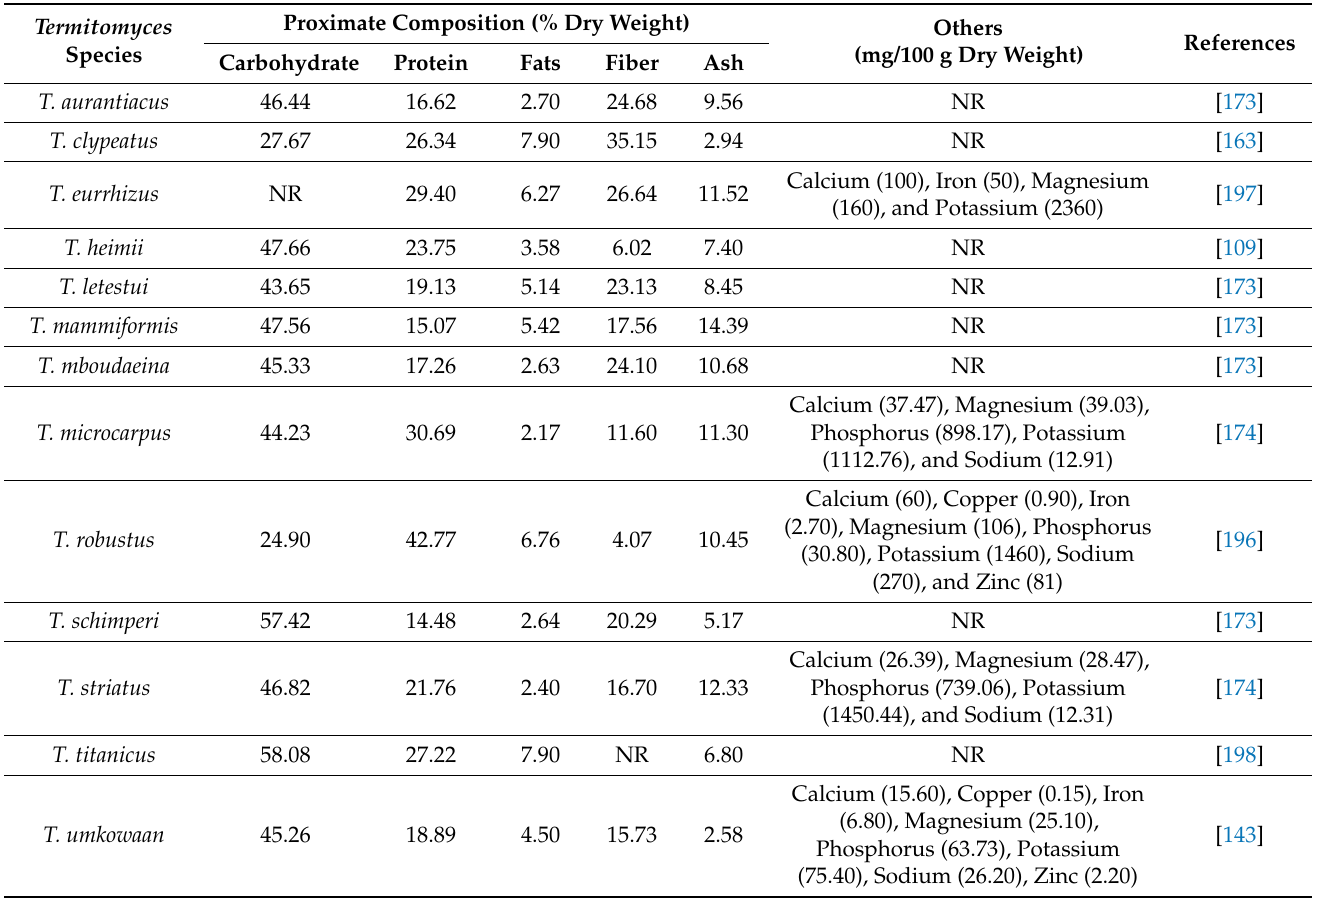
Table 3. Proximate compositions of different Termitomyces